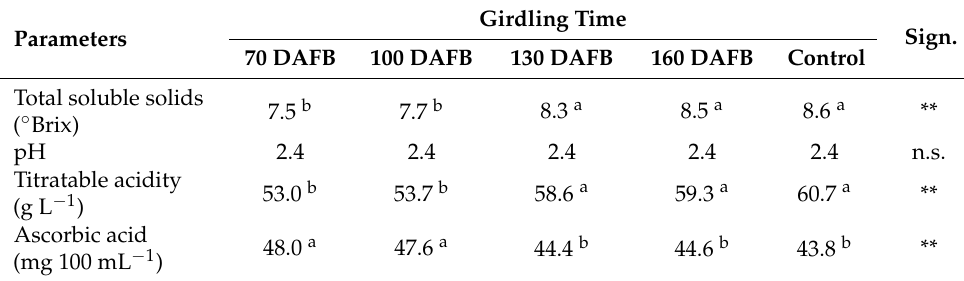
Table 4. Effects of girdling time on the main qualitative characteristics of